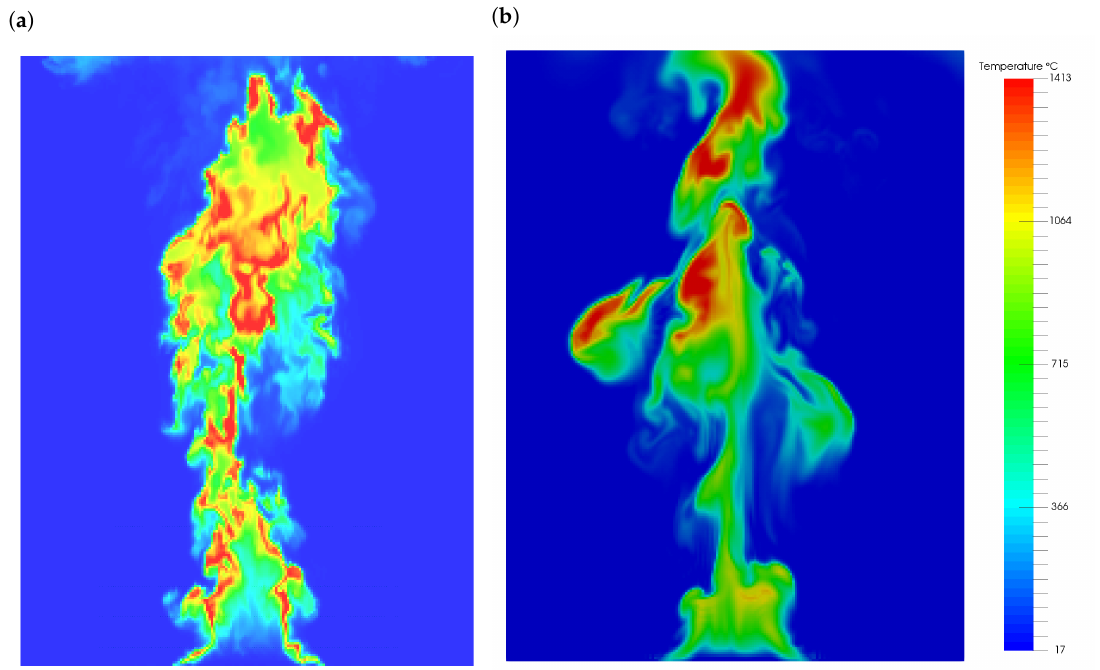
Figure 11. Sandia flame, Test 24: Instantaneous temperature field computed by FDS ( a ) and GKS ( b ) at t = 10s from the fine simulations with ∆ x =